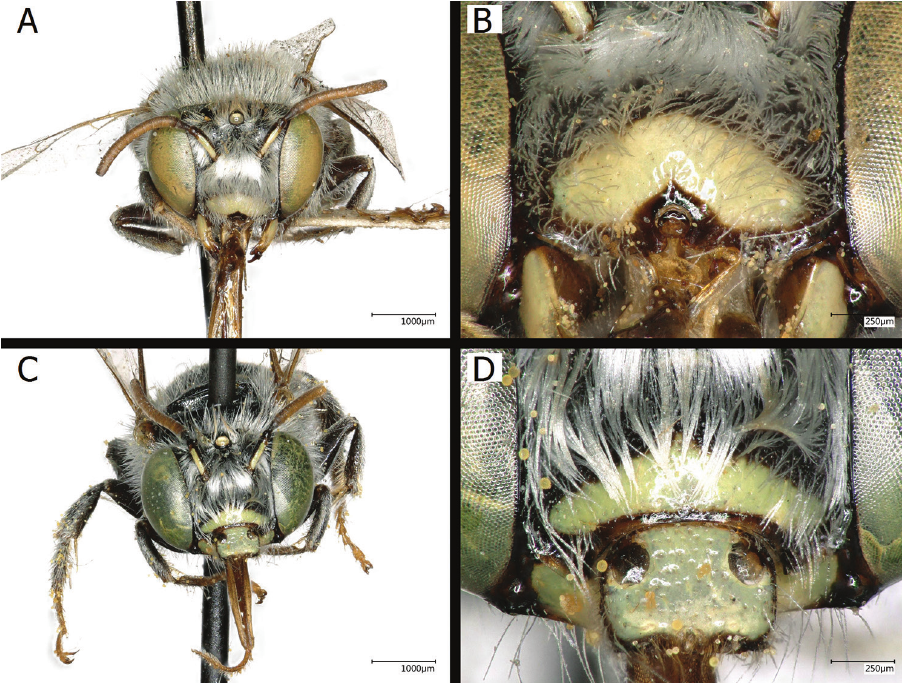
Figure 2. The deviant (UCRCENT407176) and normal (NPIC:BBSL506171) labral forms of An- thophora petrophila : A deviant, 50× magnification B deviant, 200× magnification C normal, 50× magni- fication D normal, 200× magnification. Scale bars indicate 1000µM ( A, C ) or 250µm ( B, D